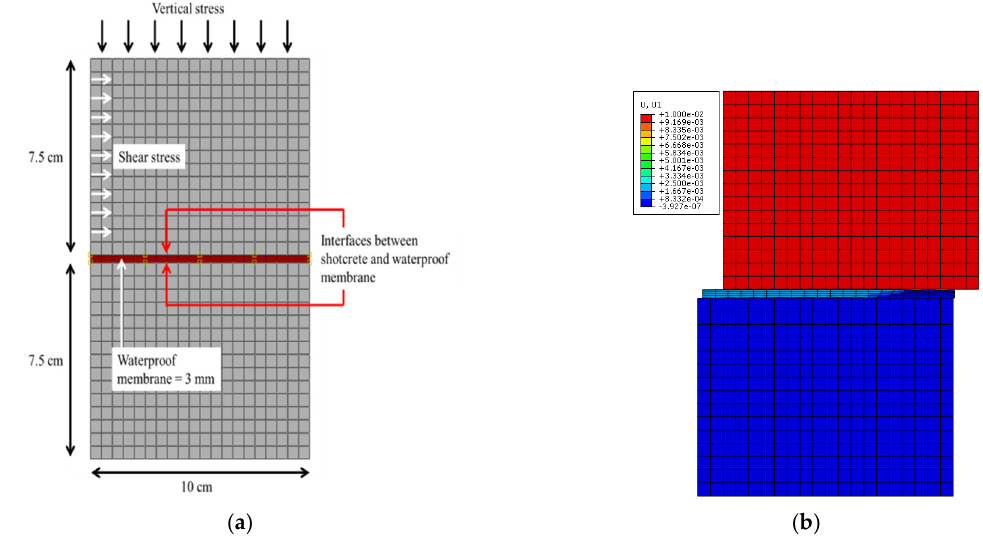
Figure 5. Direct shear test: ( a ) model and ( b ) visualization of uniform horizontal displacement.